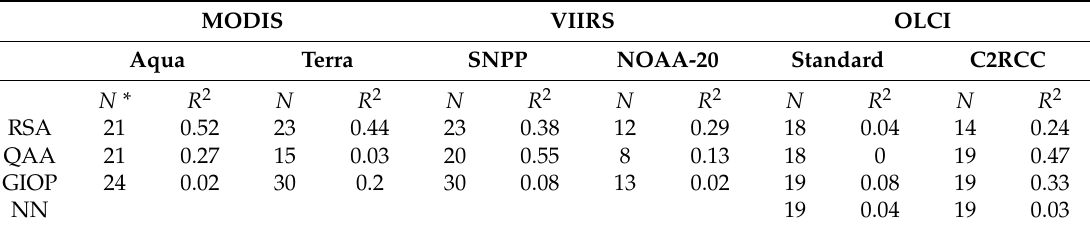
Figure 5. Regressions of satellite values a g _olci_std ( a ) and a g _olci_C2RCC ( b ) vs. measured values a g _icam. The dotted lines represent the correlations for the corresponding seas. Table 2. Regression parameters between the absorption values derived from satellite and in situ data for various algorithms and neural networks (NN) OLCI. N is the number of pairs to calculate the regression, R 2 is the coefficient of determination.